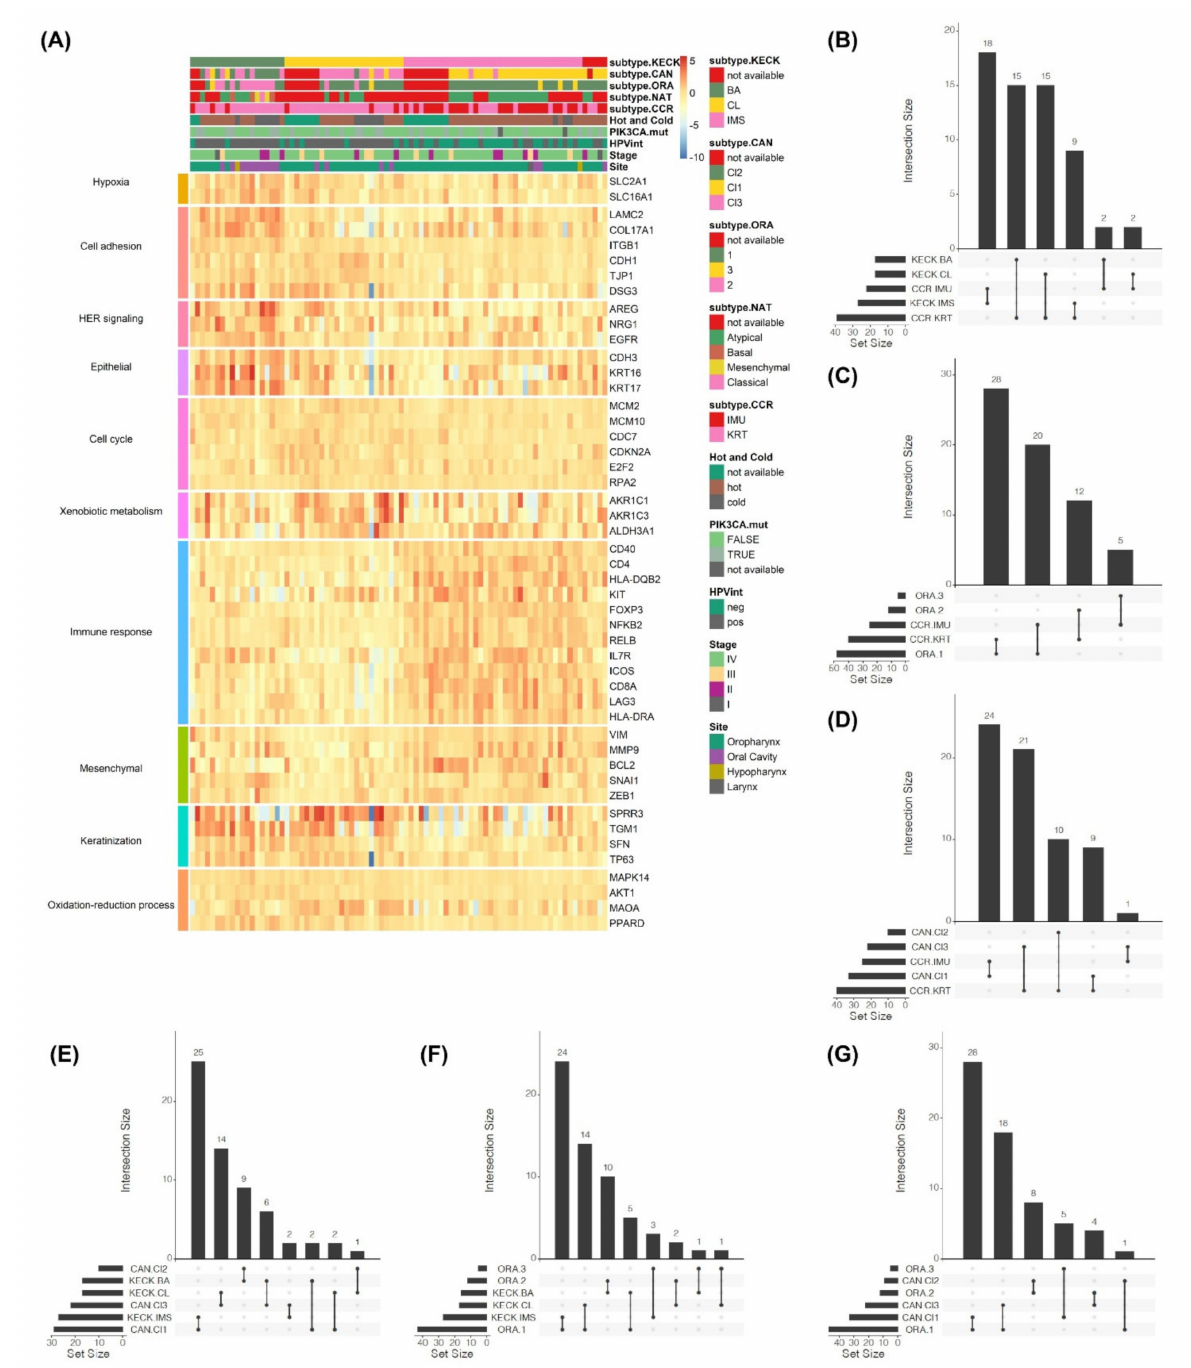
Figure 1. Comparison of the different definitions of HPV-positive head and neck subtypes: ( A ) Heatmap illustrating expression of genes and pathways previously identified as distinguishing HPV(+) subtypes; genes and pathways were combined from Keck et al. (KECK) and Zhang et al. (CCR) subtype findings, and visualized using log2FPKM values normalized (mean centered) by genes and samples. Additionally, shown are several annotations which indicate trends among subtypes and with tumor characteristics. KECK subtypes were re-designated for all 66 TCGA and 18 UM HPV(+) cases by applying their algorithm, while all other subtype definitions were obtained directly from the original publications. ( B – G ) Upset plots illustrating pairwise overlaps among subtype definitions: ( B ) KECK (BA/CL/IMS) vs. CCR (IMU/KRT), ( C ) ORA (1/2/3) vs. CCR (IMU/KRT), ( D ) CAN (Cl1/Cl2/Cl3) vs. CCR (IMU/KRT), ( E ) CAN (Cl1/Cl2/Cl3) vs. KECK (BA/CL/IMS), ( F ) ORA (1/2/3) vs. KECK (BA/CL/IMS) and ( G ) ORA (1/2/3) vs. CAN